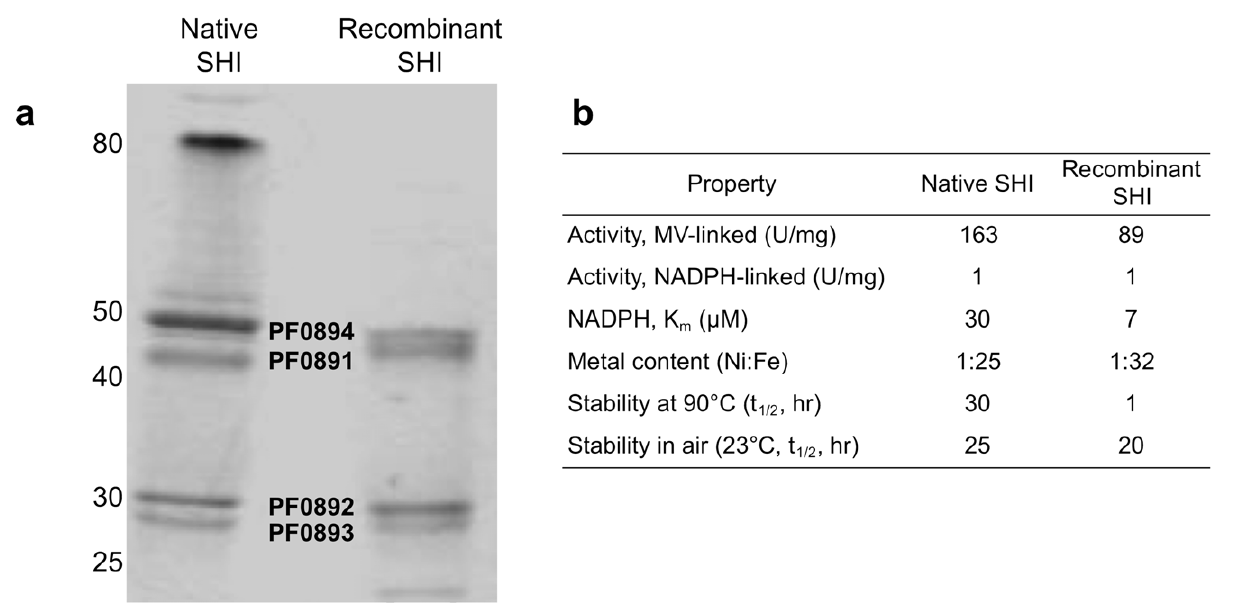
Figure 6. Properties of recombinant P.furiosus SHI. ( a ) Gel electrophoresis (SDS-PAGE) analysis of native and recombinant SHI. Bands representing the four subunits of the SHI are indicated, all of which were confirmed by MALDI-TOF analysis (data not shown). The high molecular weight band in the native protein, not seen in the recombinant version, represents undenatured tetrameric protein [11]. Recombinant PF0891 is approximately 2 kDa larger than the native protein due to the N-terminal extension (see Fig. 3). Molecular weight markers (kDa) are indicated. ( b ) Physical and catalytic properties of rSHI and the native hydrogenase purified from P. furiosus biomass. Hydrogen evolution was measured using either methyl viologen (MV) or NADPH as the electron donor at 80 u